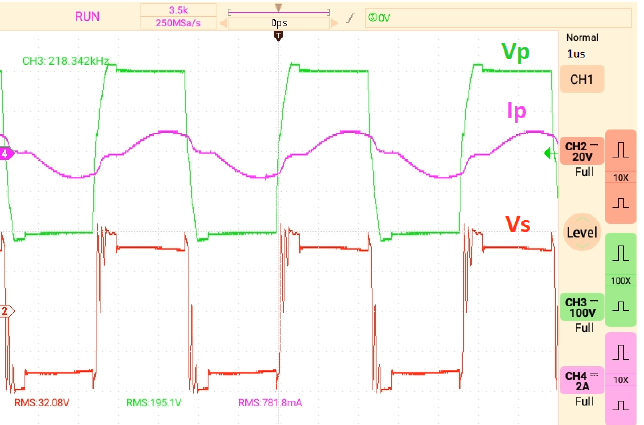
Figure 16. LLC resonant converter S-PWM experimental result V o = 29.4 V, I o = 2.3 A, f sw = 218 kHz, 75% S-PWM duty.